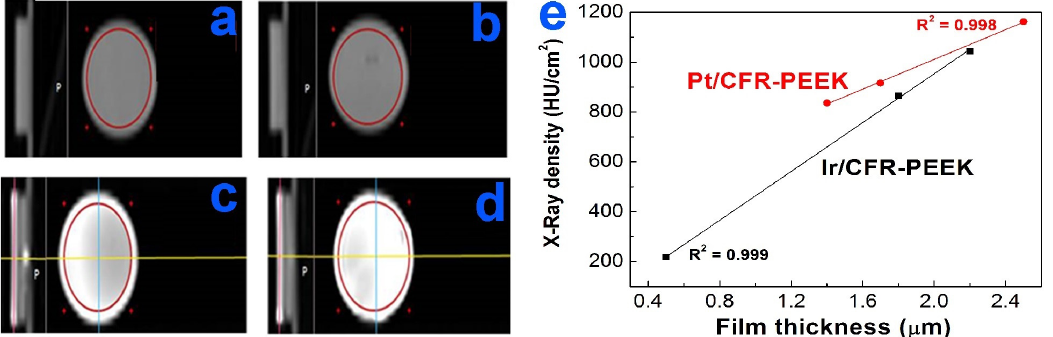
Figure 6. Magnetic resonance tomographic images of bare CFR-PEEK disc ( a ), Ir/CFR-PEEK-2 ( b ), Ir/CFR-PEEK-8 ( c ), and Ir/CFR-PEEK-12 ( d ) and dependences of X-ray density of samples on the Ir and Pt film thicknesses ( e ).